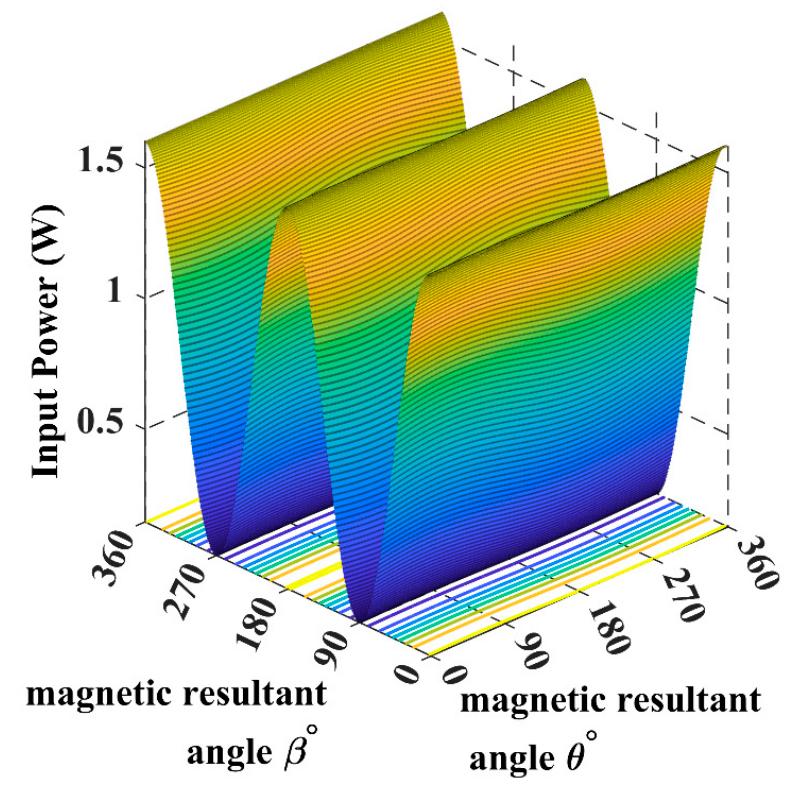
Figure 8. The input power plot for the 3D WPT system when the receiver is placed at α = φ = 0°.